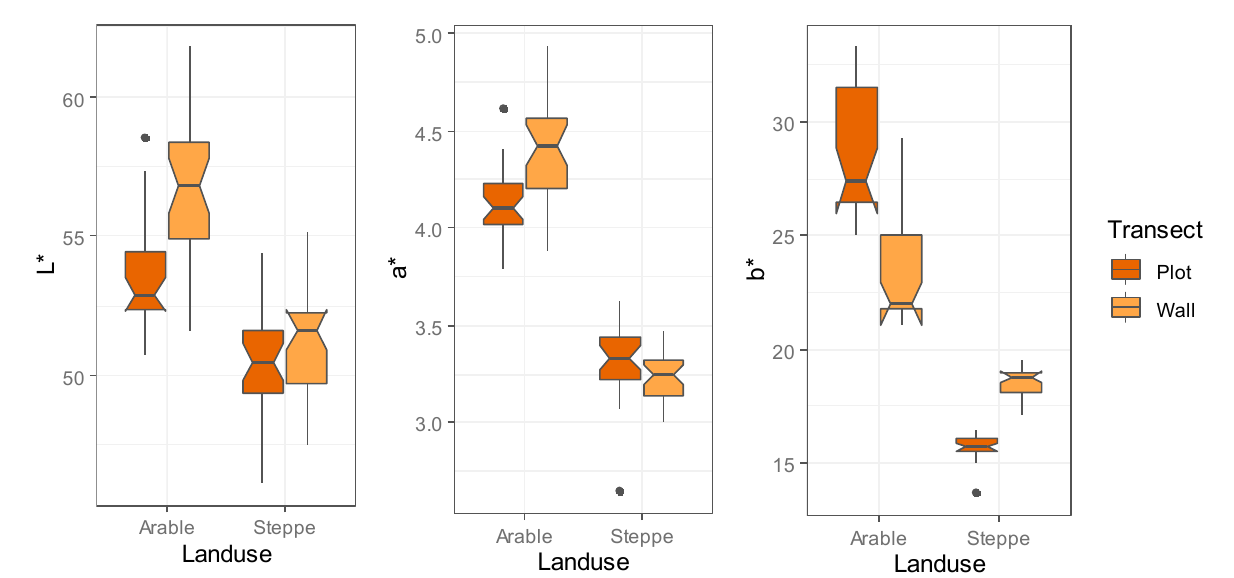
Figure 4. Boxplots of color coordinates of soil samples in the CIE 1976 (L*a*b*) color space.